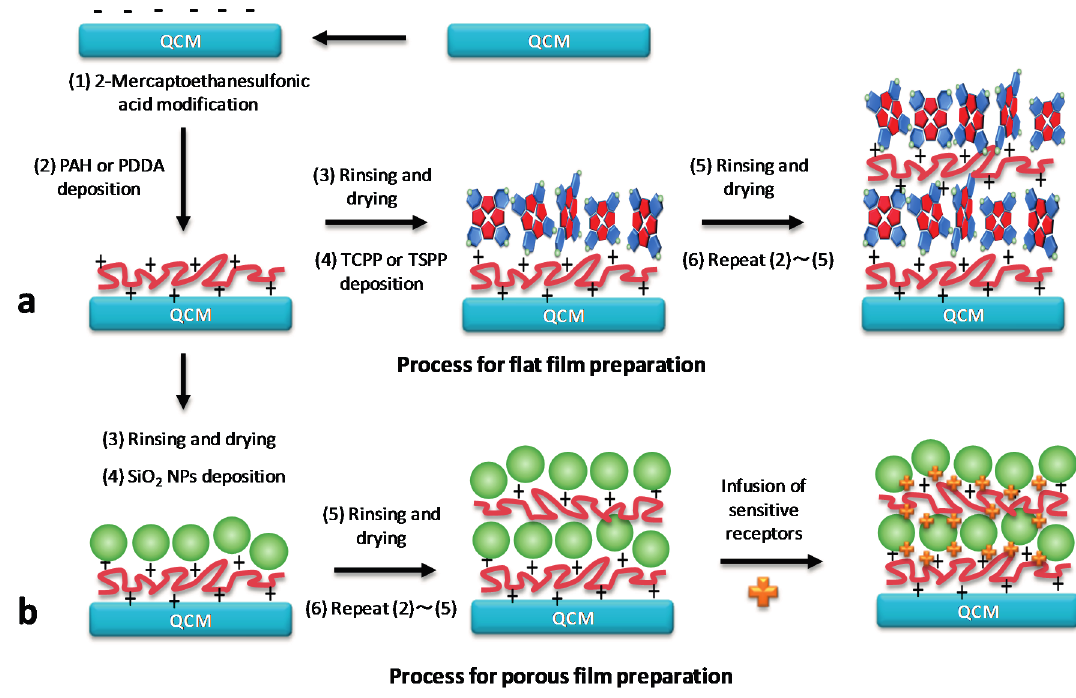
Figure 1. General illustration concept of the QCM surface modification used in the current work. ( a ) Deposition of flat film on the QCM surface; ( b ) formation of porous film on the surface of the QCM electrode, followed by infusion of a sensitive molecular receptor (modification of